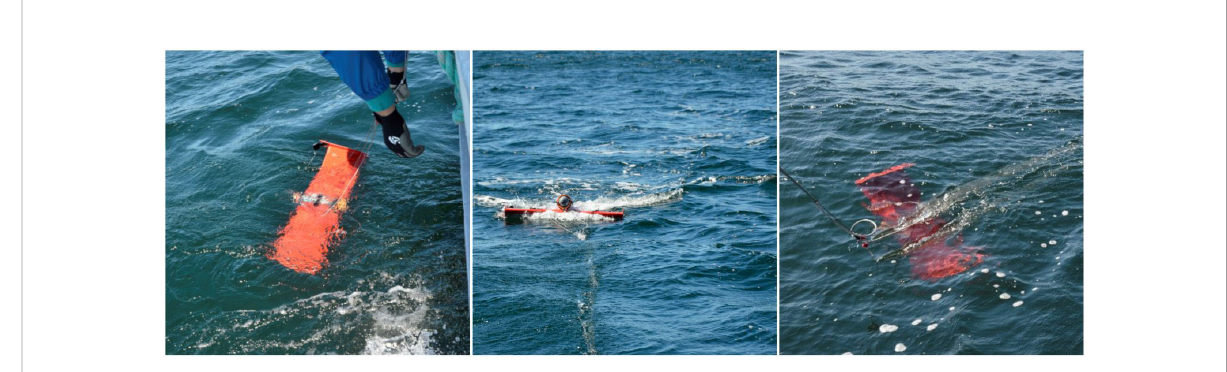
FIGURE 3 Test of fi rst prototype at the Sven Loven Centre in Sweden 2019.